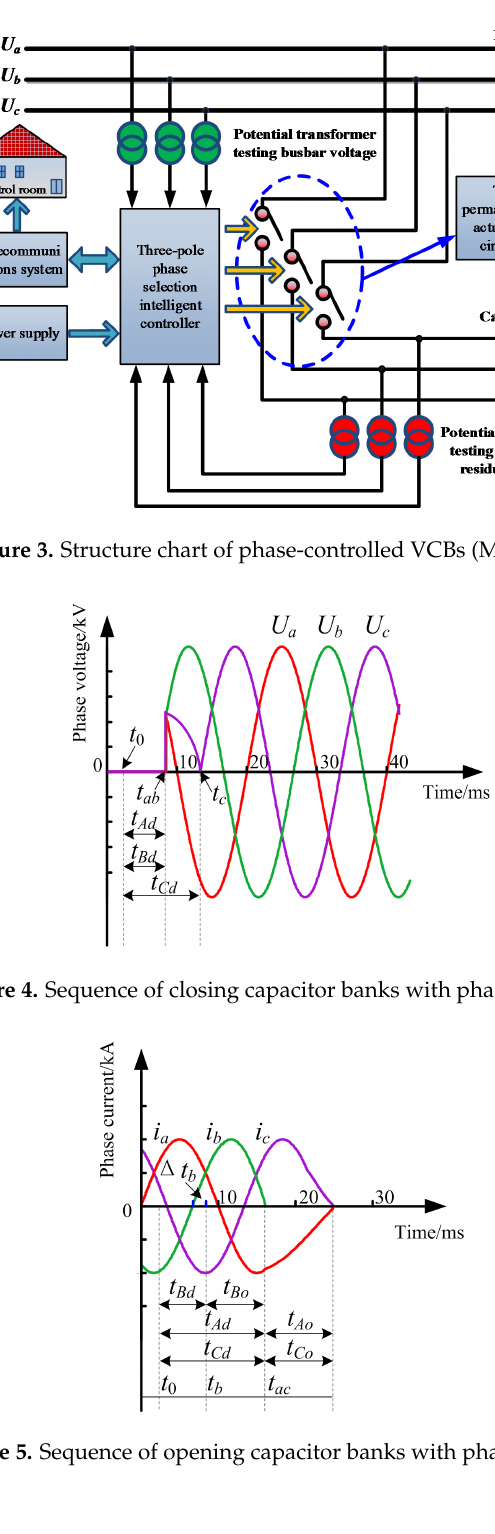
Figure 5. Sequence of opening capacitor banks with phase selection.